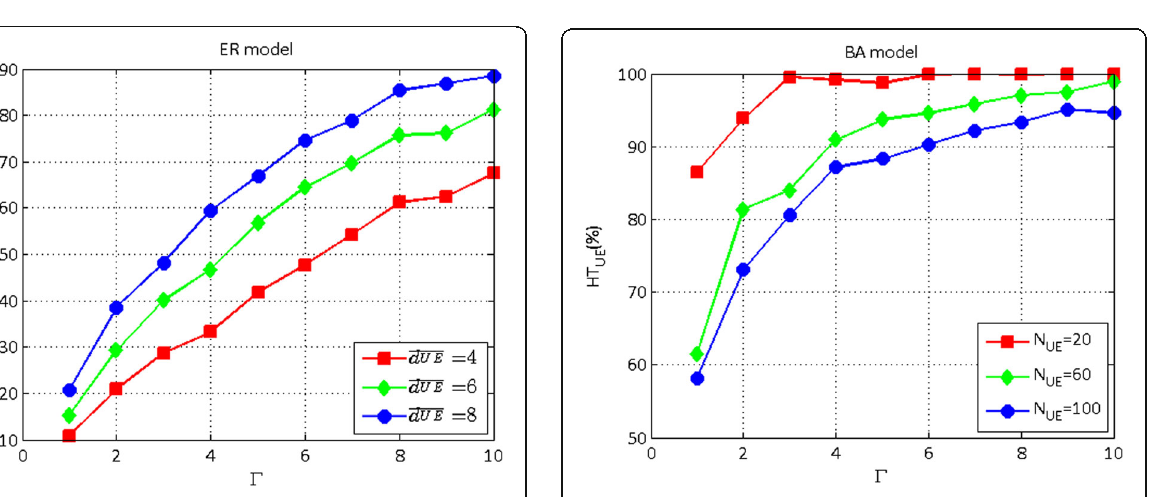
Fig. 11 Impact of average degree value to hit rate in ER Fig. 12 Impact of number of nodes to hit rate in